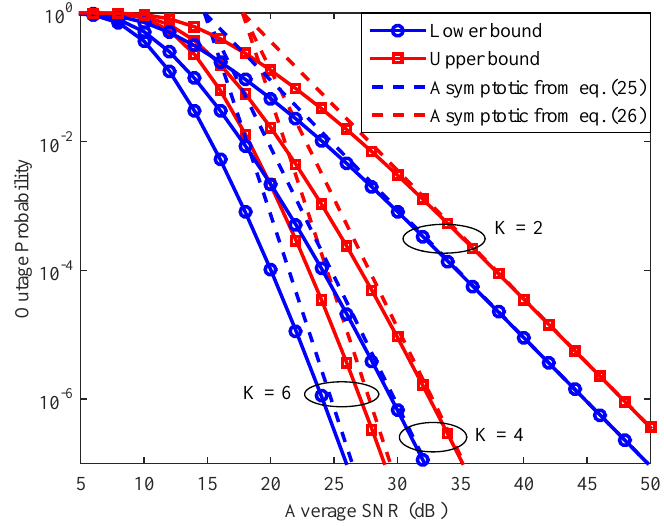
Figure 7. Upper and lower bounds on the system outage probability and their asymptotic approximations with ρ =